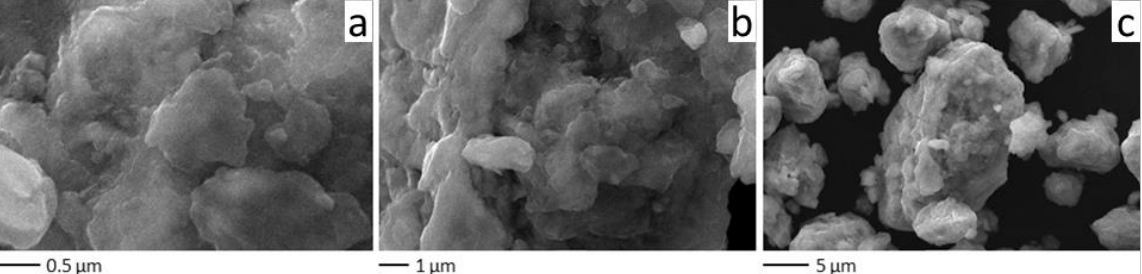
Figure 4. SEM images of the powder particles formed after 90 min of milling of the 67Cu–33Fe mixture at different magnifications ( a ) × 30,000 ( b ) × 10,000 and ( c ) ×